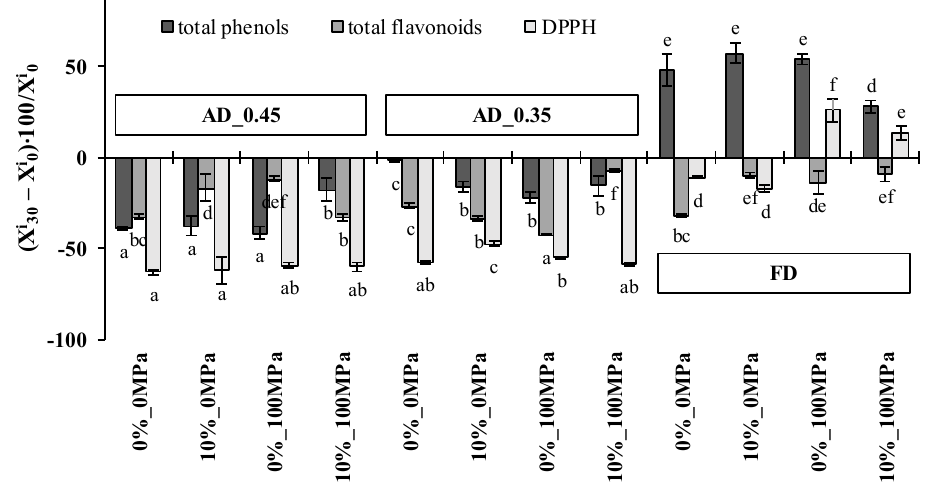
Figure 3. Antioxidant property change of apple snacks after 30 days of storage under controlled conditions. X i0 and X i30 respectively stand for the mass fraction in dry basis of component i at the beginning and at the end of the storage, VI APP stands for vacuum-impregnated apples, FD stands for freeze-dried apples, AD_0.45 stands for apples air-dried until reaching a a w ≈ 0.45 and AD_0.35 stands for apples air-dried until reaching a a w ≈ 0.35. Error bars represent the standard deviation of three replicates for each one of the di ff erent impregnation liquids. Di ff erent letters in the same series indicate statistically significant di ff erences with a 95% confidence level ( p -value < 0.05).